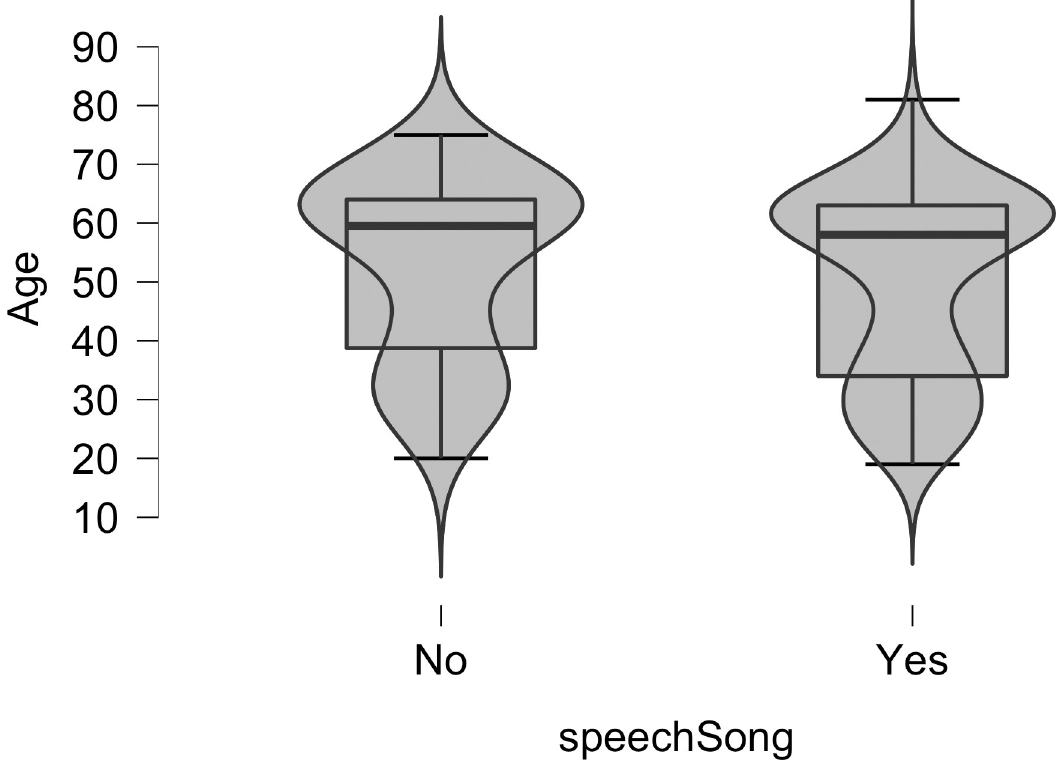
Fig 2. A violin plot with a box plot superimposed of the ages of 157 participants who did not (no) and who did (yes) experience the Speech-to-Song Illusion. The violin plot shows the distribution of ages for each response. The box plot shows the median age (the dark horizontal lines), the 75 th to the 25 th quartiles (the boxes), and the upper and lower boundaries of 1.5 � 75 th (or 25 th ) quartiles (the whiskers).